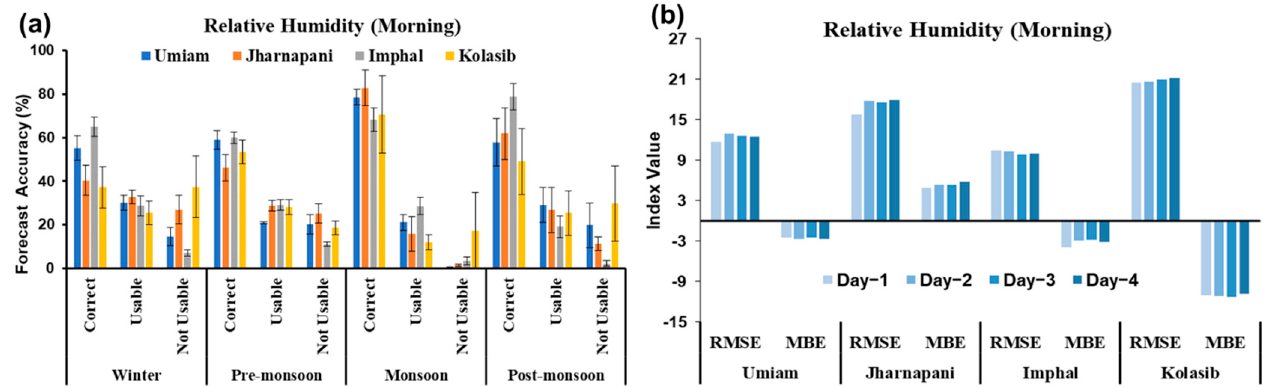
Figure 4. Quantitative ( a ) and statistical evaluation ( b ) of RH (morning) forecast over distinct locations places of the northeastern hill region of India.